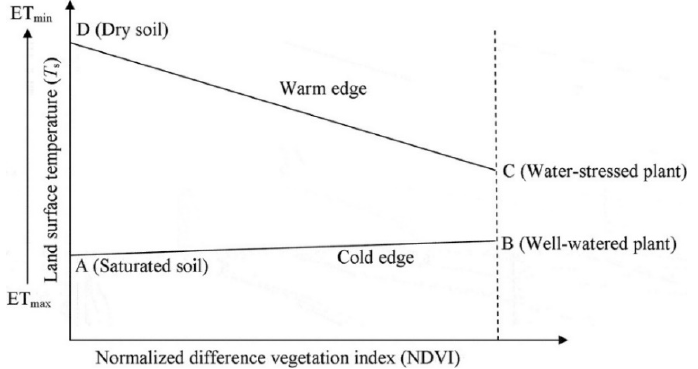
Figure 2. The trapezoidal shaped distribution of a T s –NDVI (Normalized Difference Vegetation Index) conceptual framework.